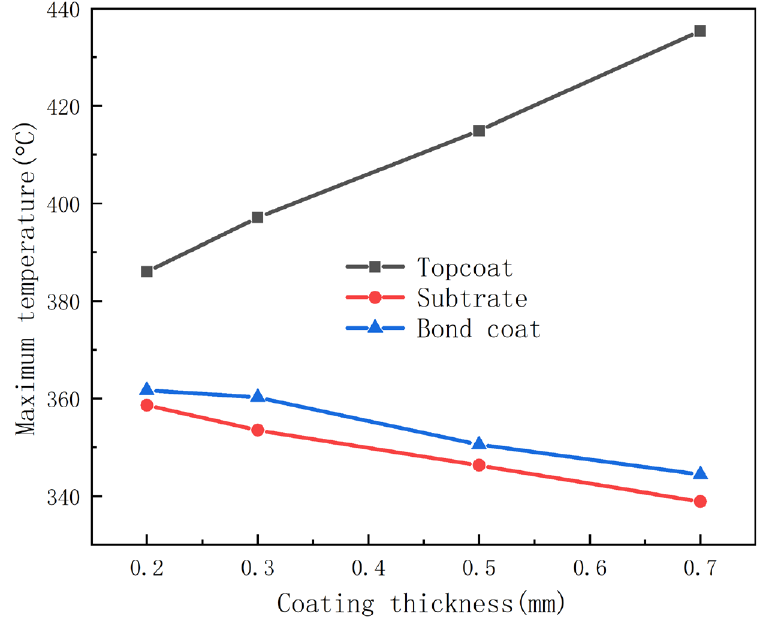
Figure 11. Maximum temperature distribution with the thickness of the coating.